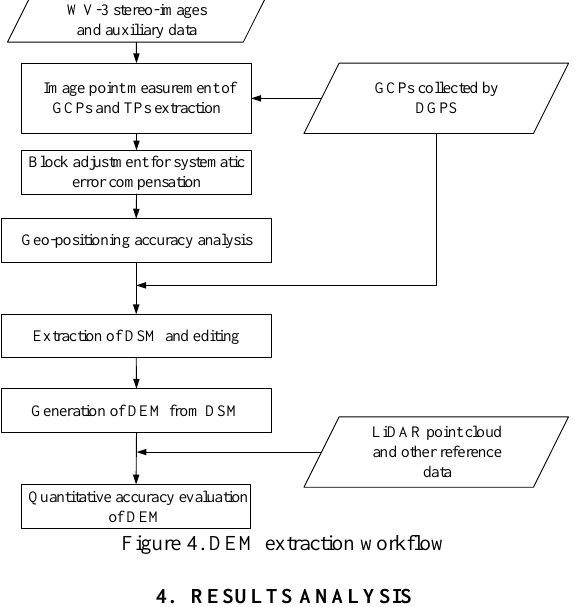
Figure 4. DEM extraction workflow